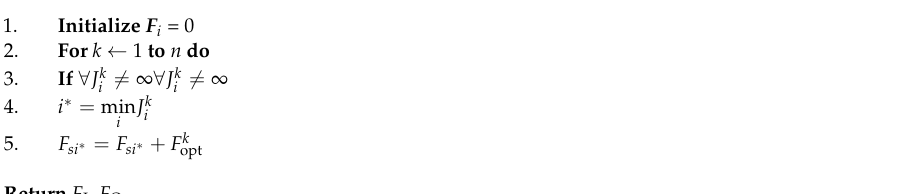
Algorithm 1. Procedure for best suspension force distribution with minimal energy